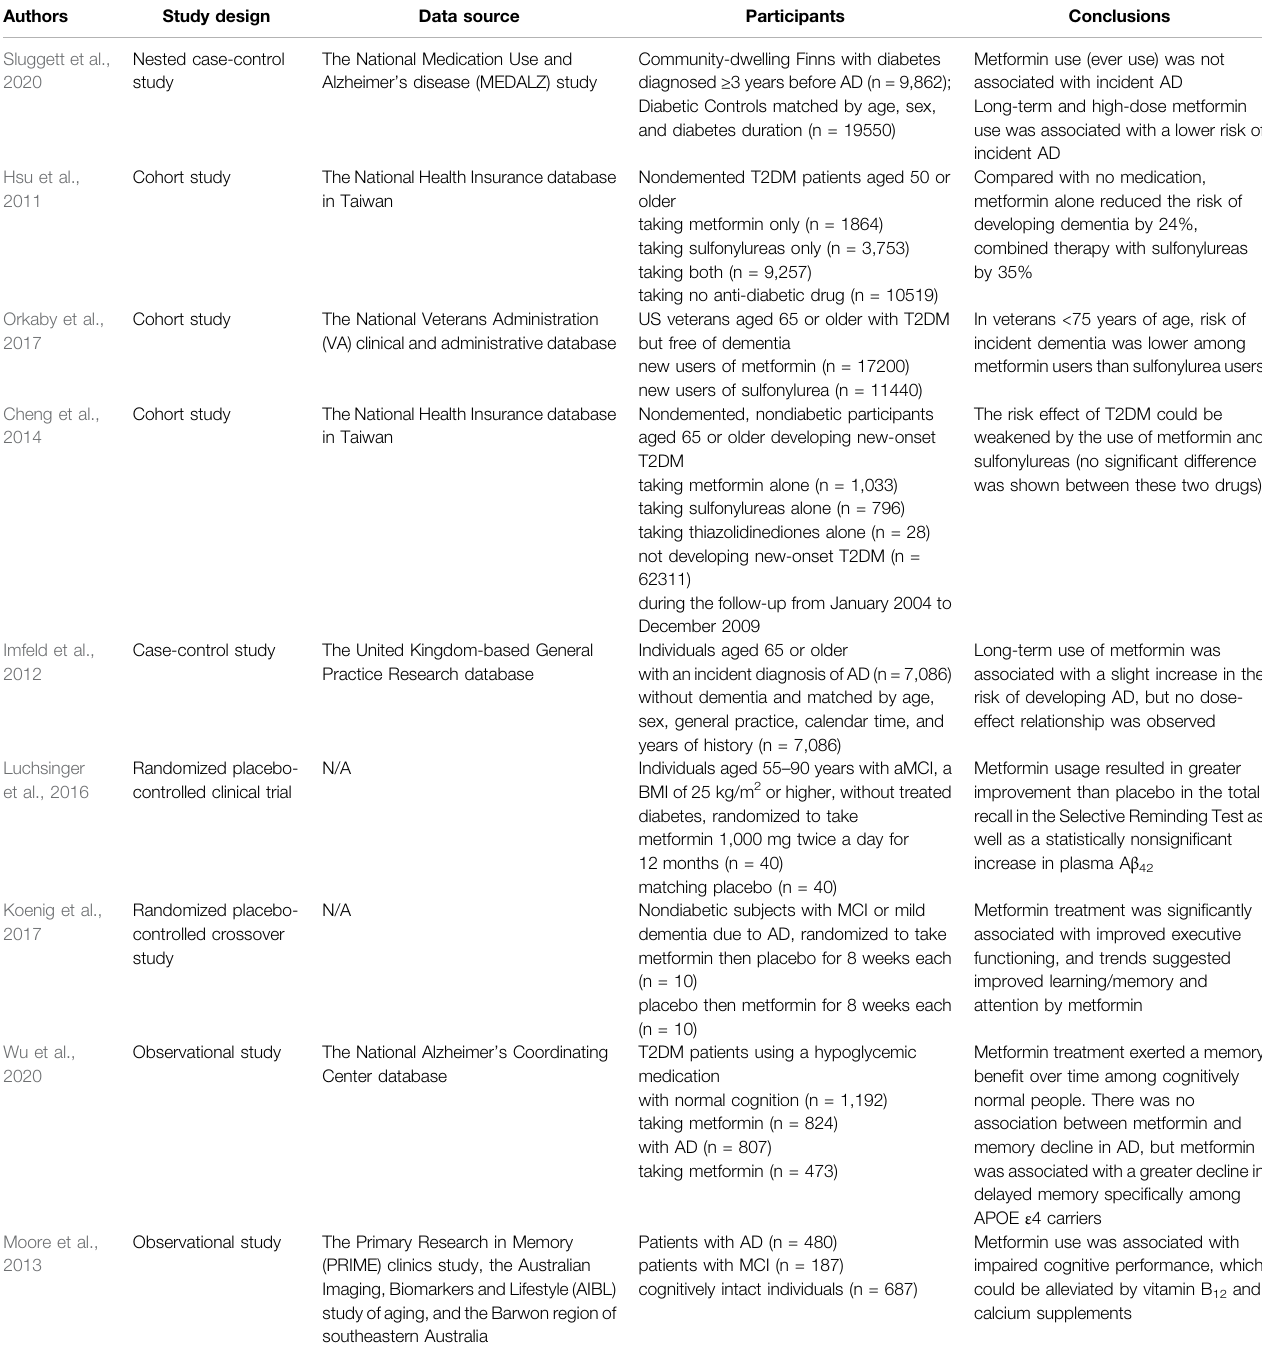
TABLE 1 | Representative clinical studies on the effects of metformin on AD. AD, Alzheimer ’ s disease; MCI, mild cognitive impairment; T2DM, type 2 diabetes